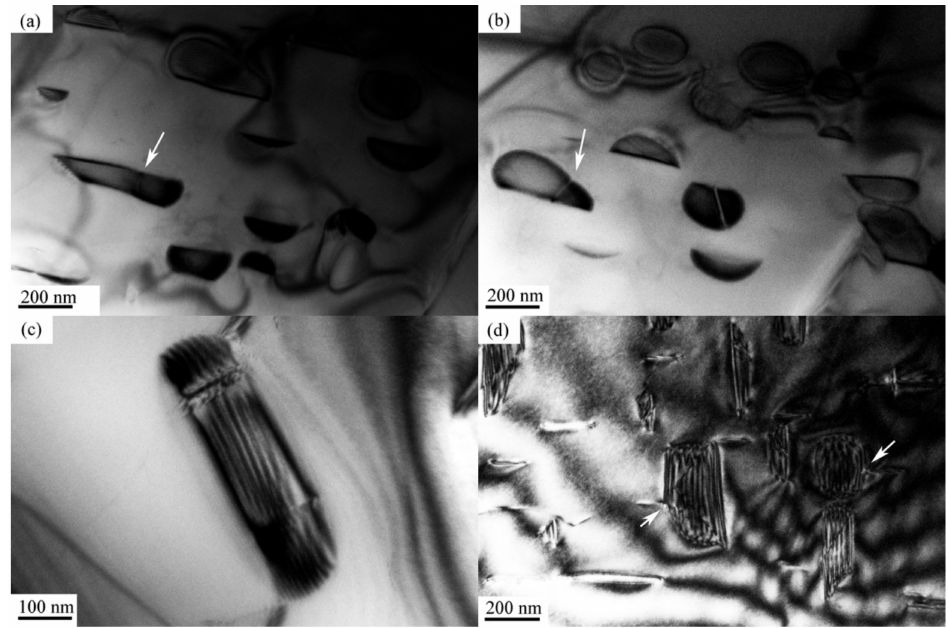
Figure 5. TEM images of ( a ) trapezoidal abnormal growth of γ ” phase after isothermal aging at 900 ◦ C for 8 h; ( b ) disc-shaped abnormal growth of γ ” phase after isothermal aging at 900 ◦ C for 8 h; ( c ) planar faults within irregular rectangle-shaped γ ” phase after isothermal aging at 900 ◦ C for 11 h; ( d ) planar faults extending from γ ” phase to matrix after isothermal aging at 900 ◦ C for 11